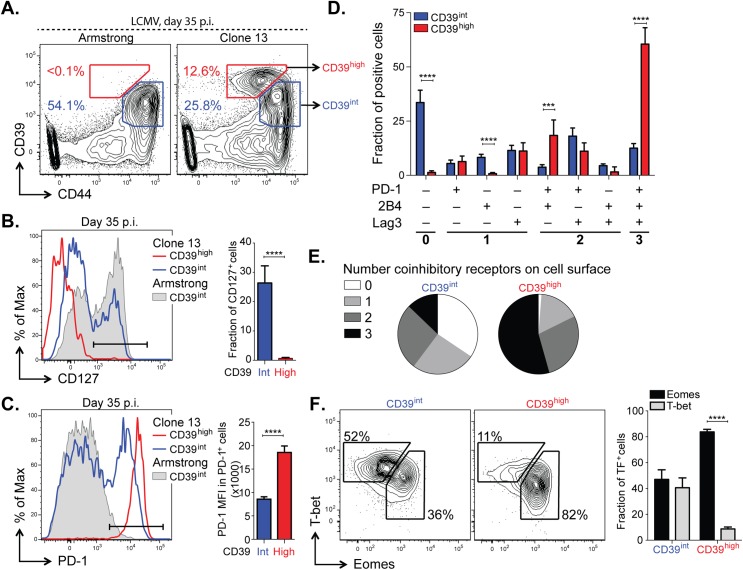
CD39 identifies terminally exhausted CD8+ T cells in mice with chronic LCMV infection.(A) Expression of CD39 and CD44+ by mouse CD8+ T cells 30–35 days following LCMV Armstrong (left) or Clone 13 (right) infection. (B, C) Representative histograms (left) of CD127 (B) and PD-1 (C) expression by CD39high and CD39int CD8+ T cells from Clone 13 (red and blue, respectively) and CD39int from Armstrong (filled gray) infected mice on d35 p.i. (left). Fraction of CD127+ (B) and MFI of PD-1 in PD-1+ cells (C) is shown on the right. Results are from 5 mice. (D) Fraction of CD39high and CD39int CD44+ CD8+ T cells expressing different combinations of co-inhibitory receptors PD-1, 2B4, and Lag3. (E) Average number of co-inhibitory receptors expressed by CD39int (left) or CD39high (right) CD8+ T cells at d35 p.i. following LCMV Clone 13 infection. (F) Representative plots of T-bet and Eomes expression in CD39int (left) and CD39high (right) cells as in (A). Summary of results is shown on the right. Data are representative of three experiments of 5 mice per group. Statistical significance was assessed with Student’s t-test (B, C, F) with Holm-Sidak multiple comparison correction (D). **P < 0.01, ****P < 0.0001.